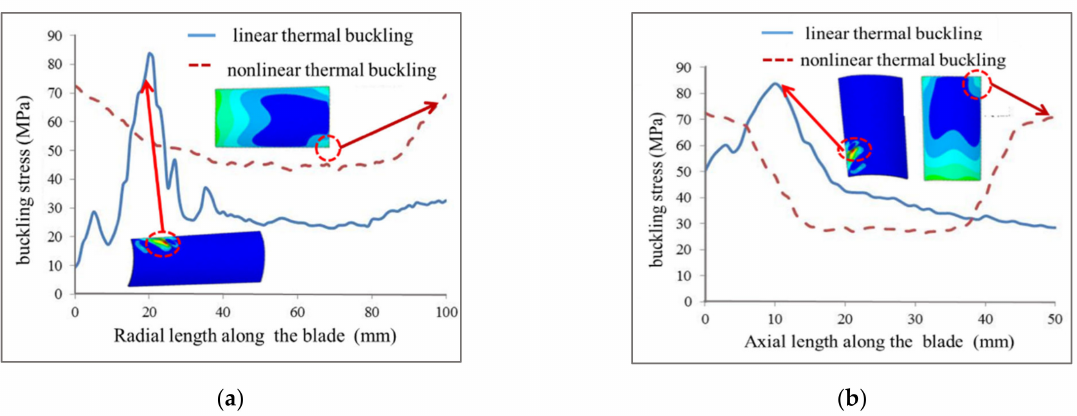
Figure 15. The radial distribution buckling deformation along the blade. ( a ) The radial distribution along the blade; ( b ) the axial distribution along the blade.